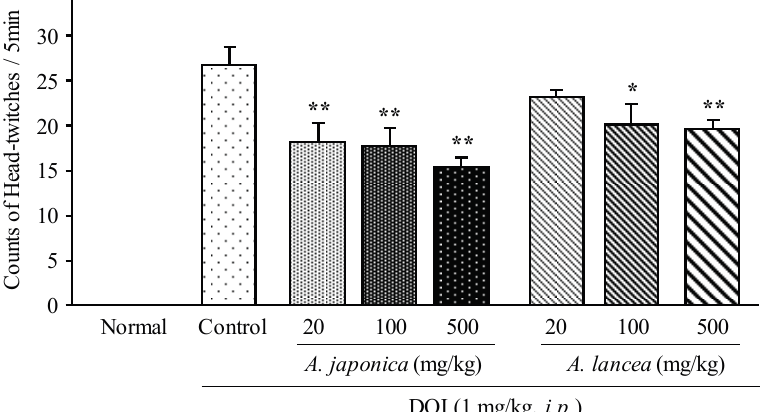
Figure 1. Effect of Byaku-jutsu and So-jutsu extracts on DOI-induced HTR in mice. Each column represents the mean ± S.E. of nine mice. * p < 0.05, ** p < 0.01 vs. Control (one-way ANOVA followed by Dunnett’s